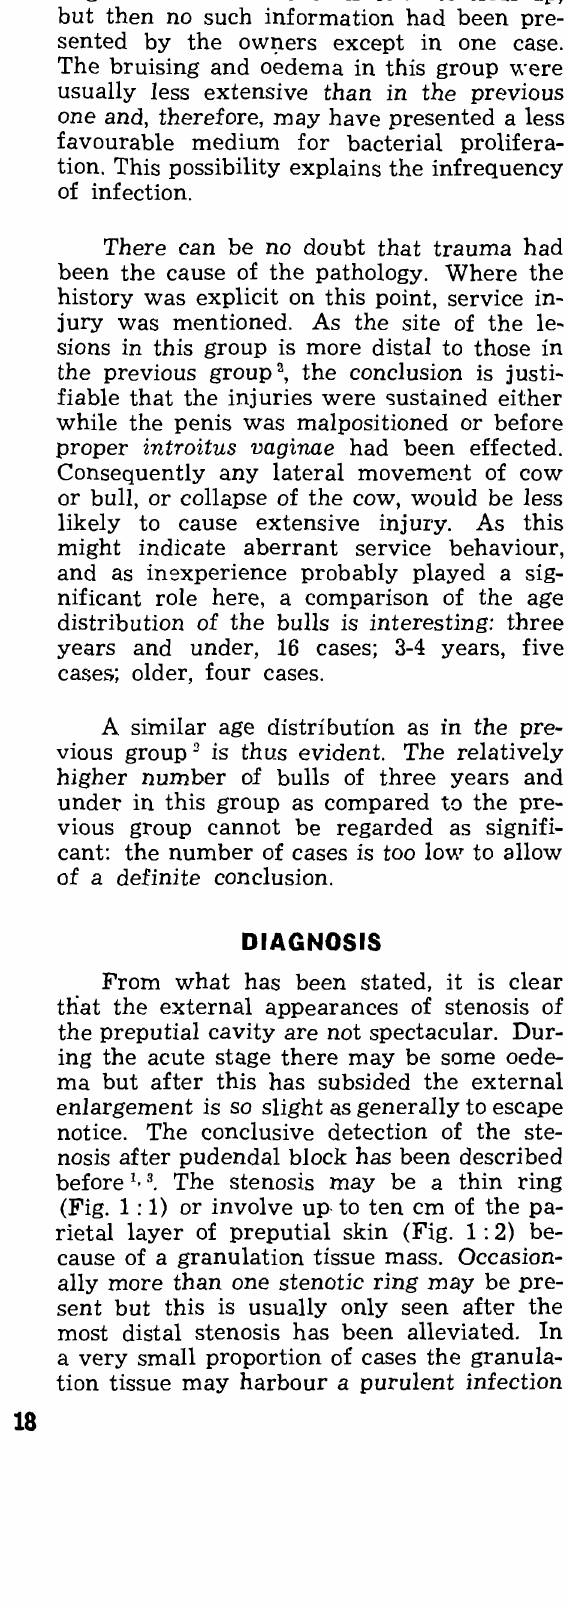
(Fig. 1 : 1) or involve up· to ten cm of the pa rietal layer of preputial skin (Fig. 1: 2) be cause of a granulation tissue mass.